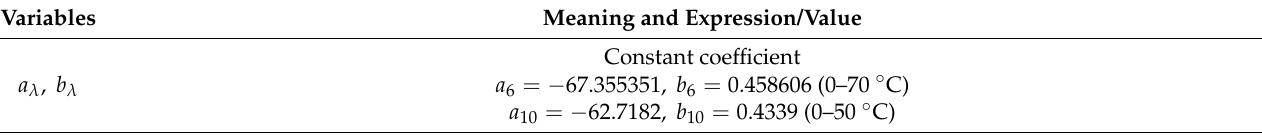
Table 1. Variables and description in the formula of the mono-window algorithm [36–40].